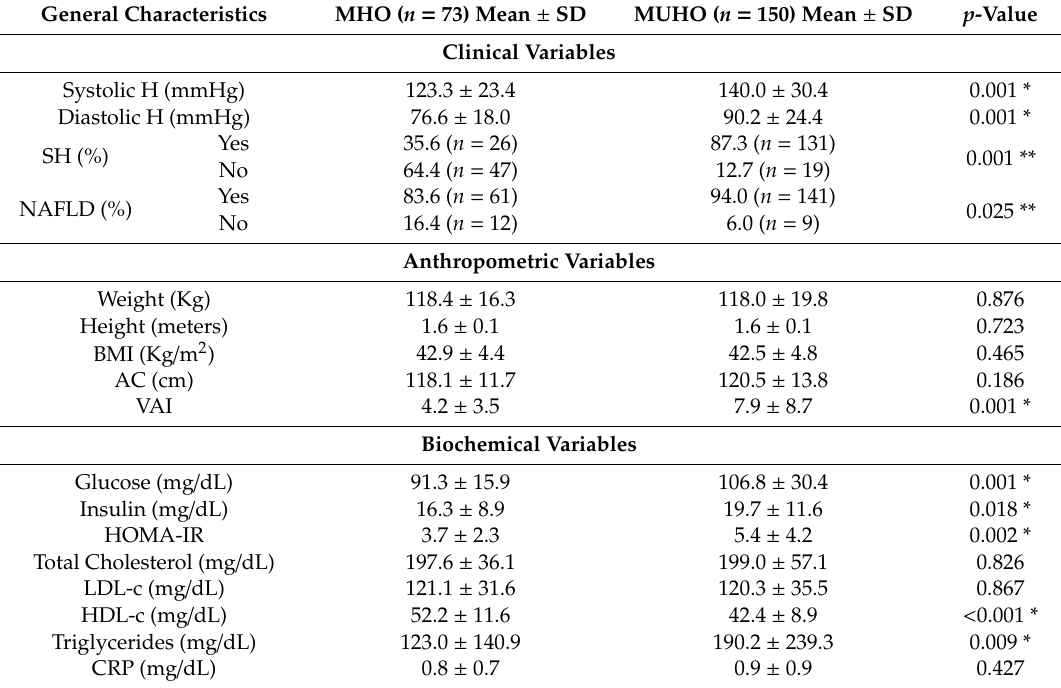
Table 1. Clinical, biochemical and anthropometric characteristics of the metabolically healthy obese (MHO) and metabolically unhealthy obese (MUHO)